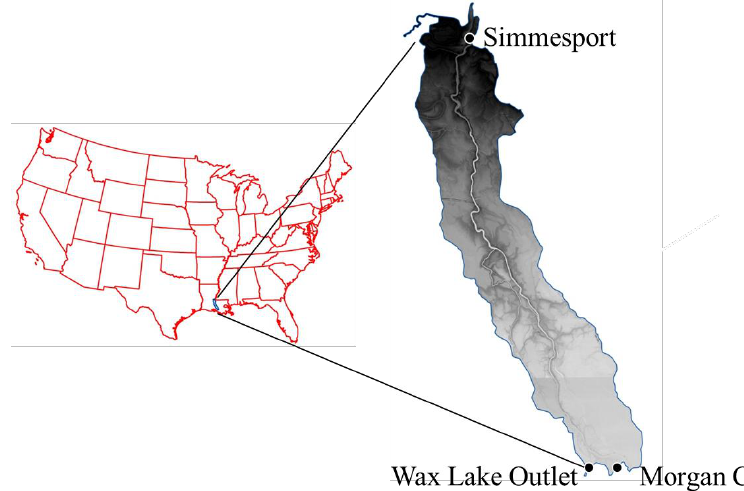
Figure 1. Geographical location of the Atchafalaya River Basin. Discharge and water quality records were obtained at Simmesport (upstream location) and Wax Lake and Morgan City (downstream locations). The river distance from Simmesport to Morgan City is approximately 182